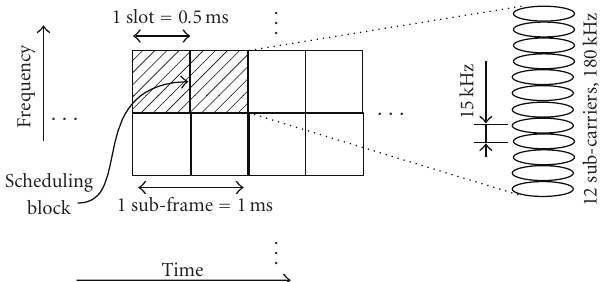
Figure 1: Illustration of a scheduling block in LTE downlink.